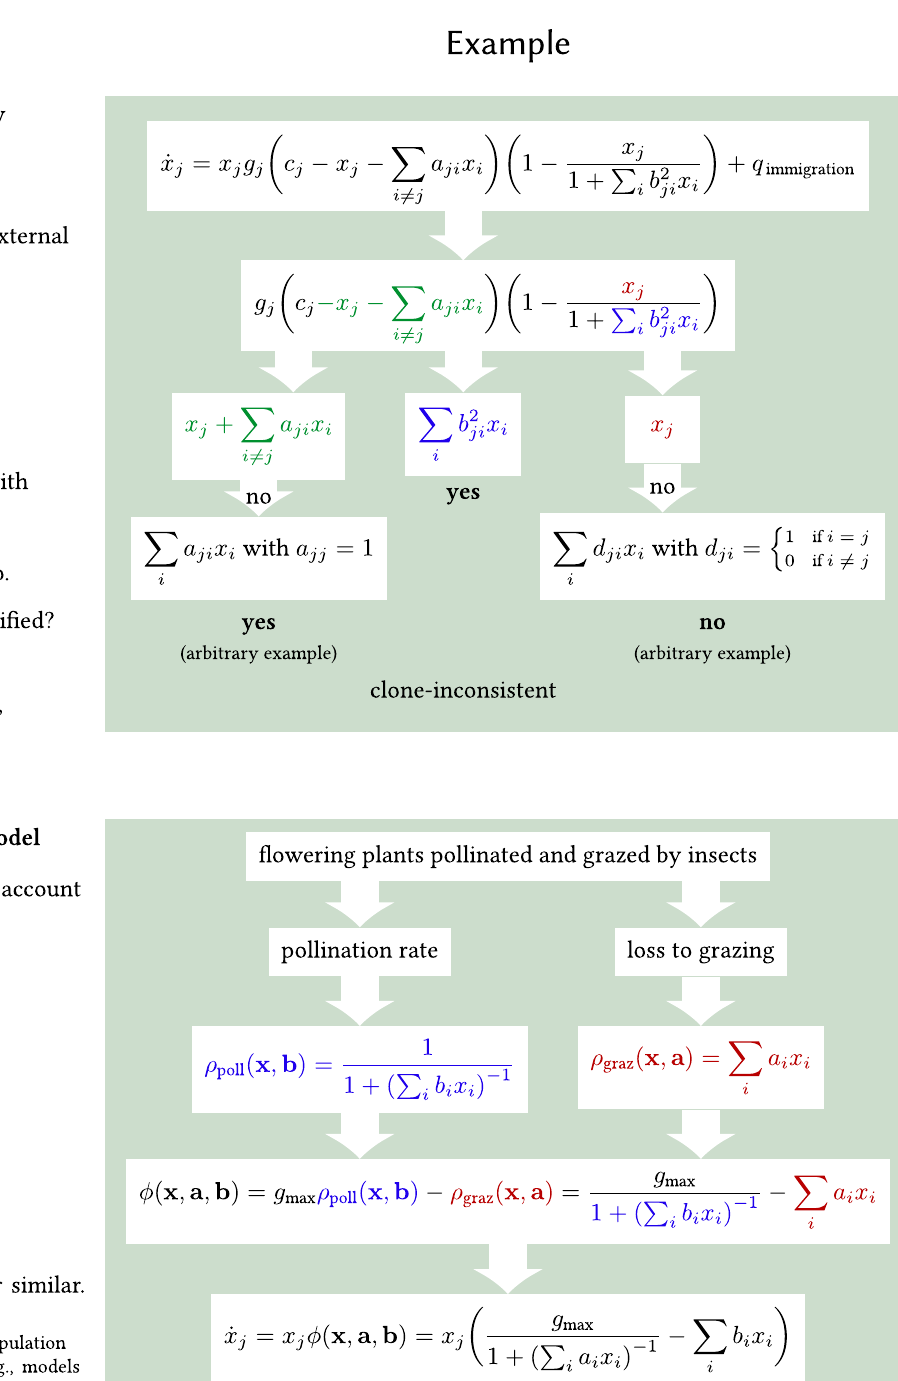
Fig 3. Recipes for building and validating models using our framework. In general x describing its impact. The example for checking is based upon Eq 21 and tailored for covering relevant cases. The example for building extends the one from The form of impact functions . For both examples, the biological background is discussed in more detail in the main text.